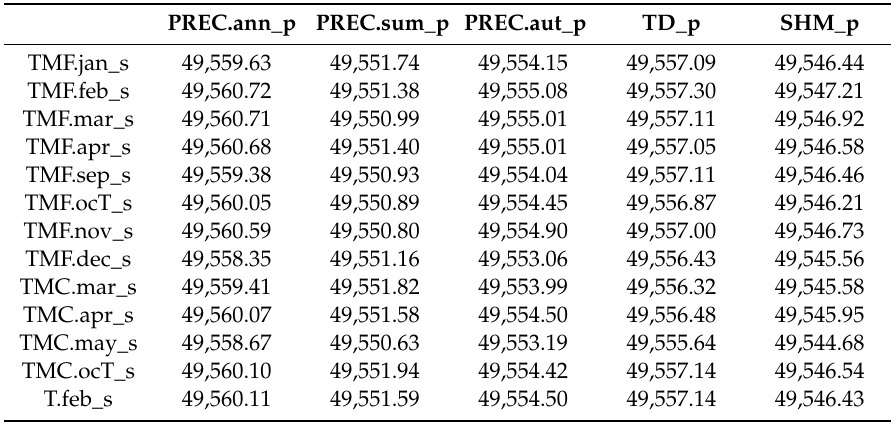
Table A2. AIC values from the battery of linear-mixed e ff ect models fitted. Climate variables of the planting sites are specified with _s and climate at the populations’ origin with _p. The best supported model showed the lowest AIC and it is highlighted with